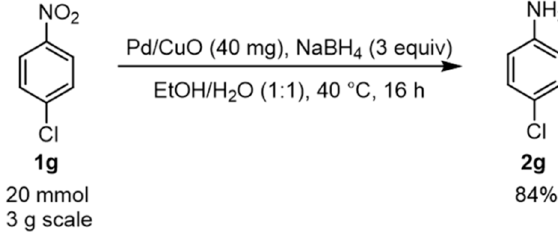
Figure 3. Gram-scale reaction.